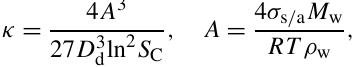
number concentration during DOYs 110–118 is shown in Figs. S2–S10 in the Supplement. At 18:00–21:11 LT